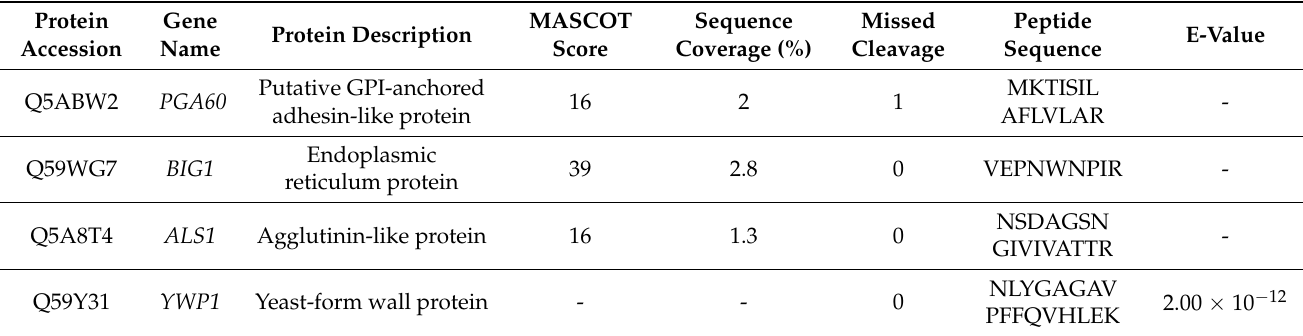
Table 2. Proteins involved in adhesion were identified in the fluconazole-resistant C. albicans strain. Proteins identified using MASCOT are represented with sequence coverage while proteins identified using BLAST are represented with E-value.